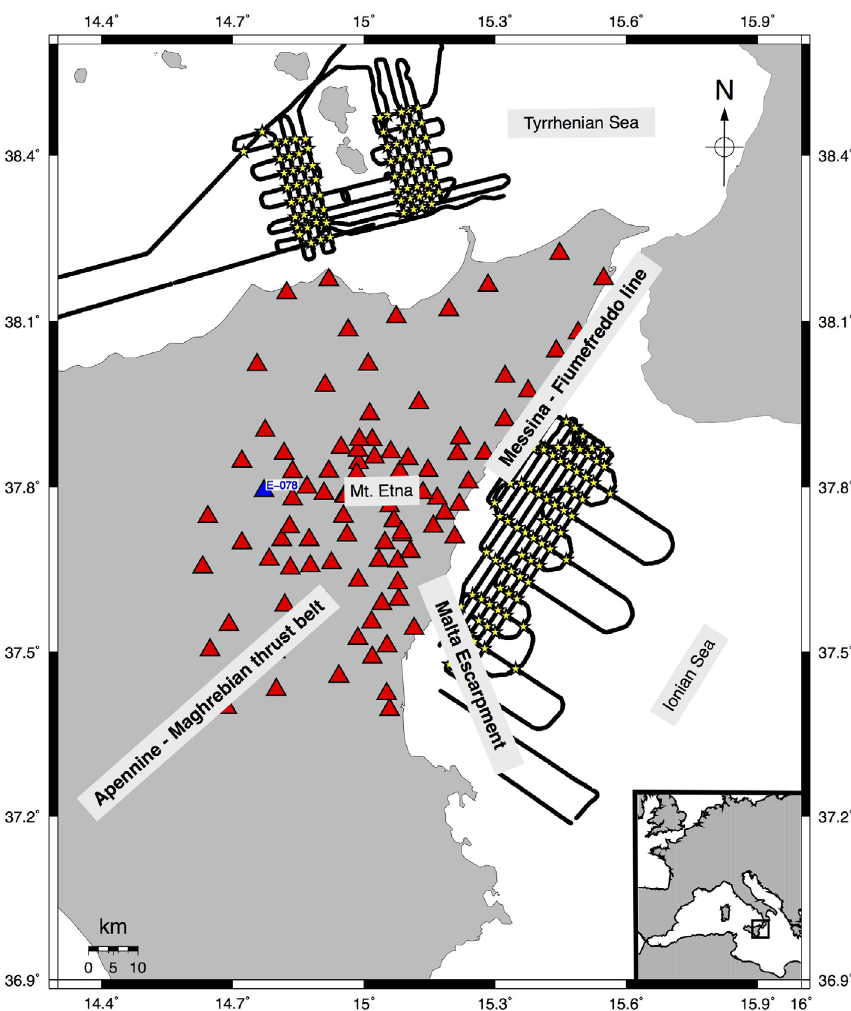
Figure 1. Overview of the main geological structure of Mt. Etna, as well as the used station net- work (red triangle) and the intersection points used for locating the ring segments for stacking (yel- low stars) on the shot lines (black lines). Data examples are shown for station E078 (blue